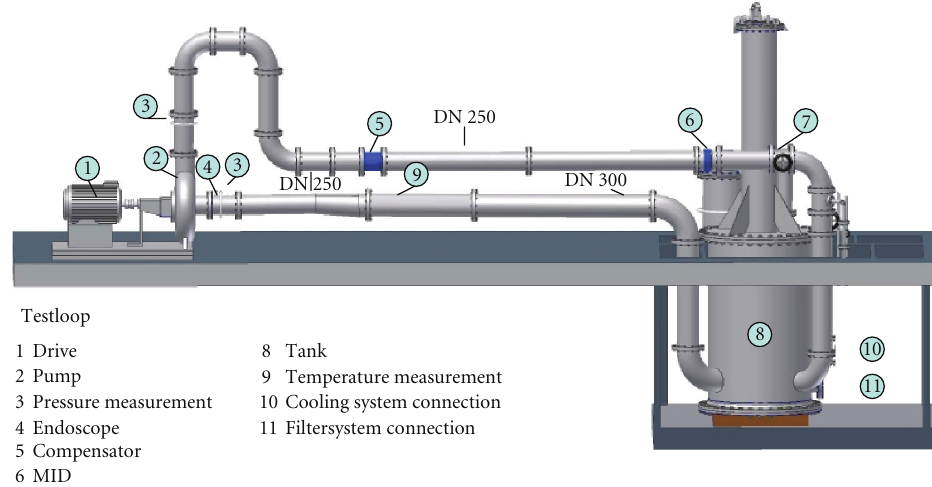
Figure 4: Instrumentation of the test loop.